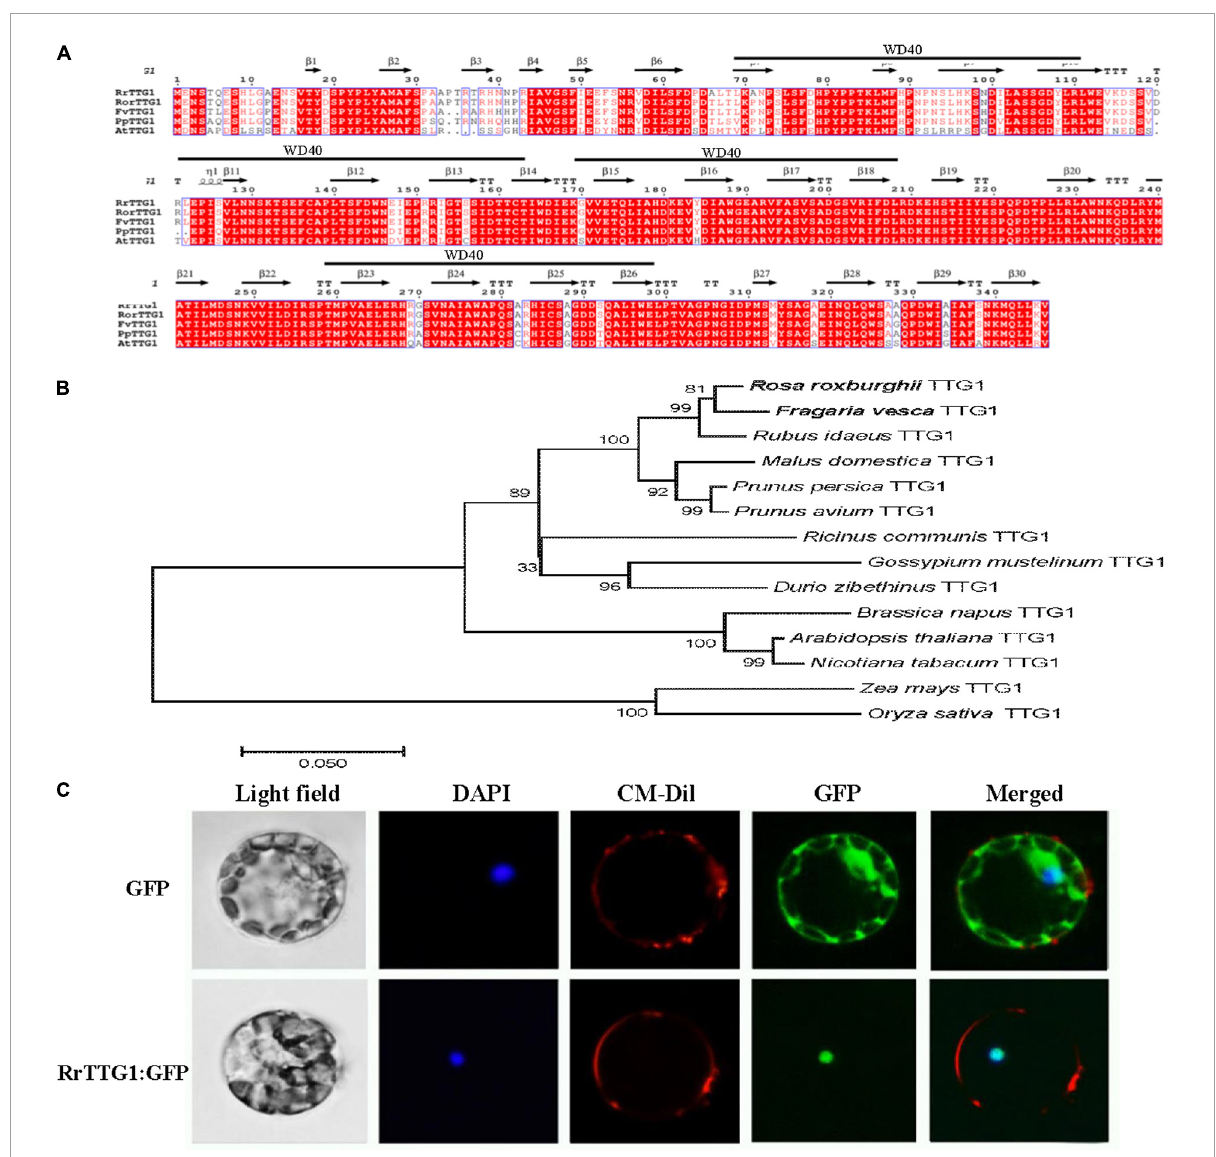
FIGURE2 Alignment, phylogenetic, and subcellular analysis of RrTTG1. (A) The deduced amino acid sequence of RrTTG1 compared to TTG1 homologs from Rosa rugosa , Fragaria vesca , Prunnus persica, and Arabidopsis . Alignments were performed using Clustal W. The secondary structure was displayed above the sequences. Red shading indicated identical amino acids. The above black line represents the WD40 domain. (B) Phylogenetic analysis of TTG1 homologs in R. roxburghii and the other plants. The scale bar indicates the number of amino